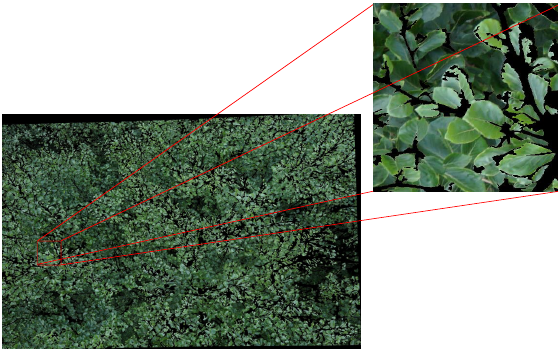
Figure 2. Structure of a curled leaf